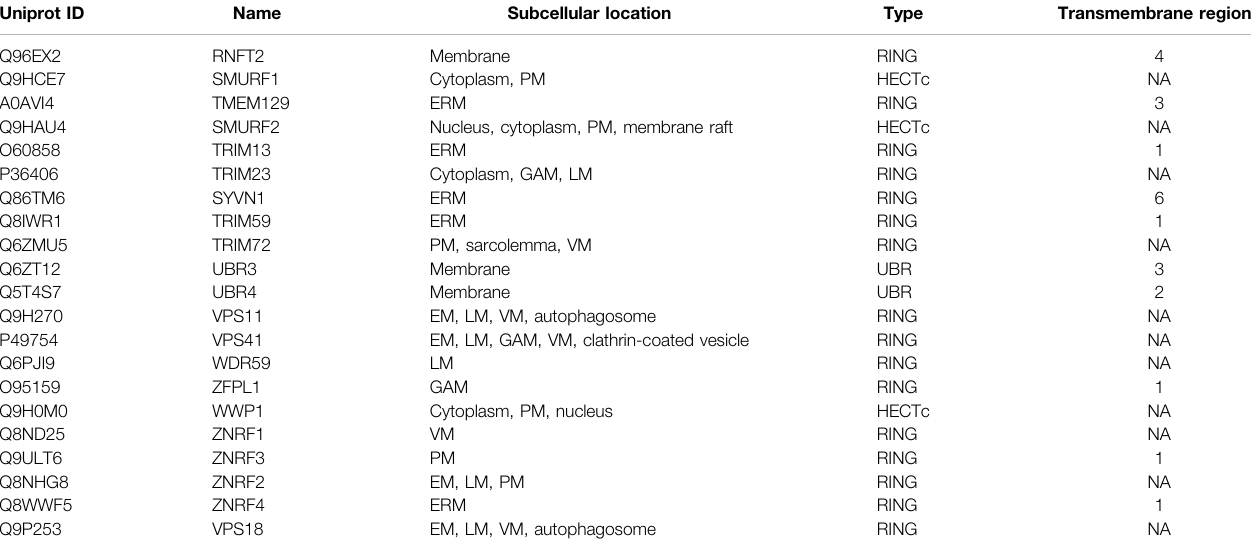
TABLE 1 | ( Continued ) 84 membrane-associated E3 ligases.